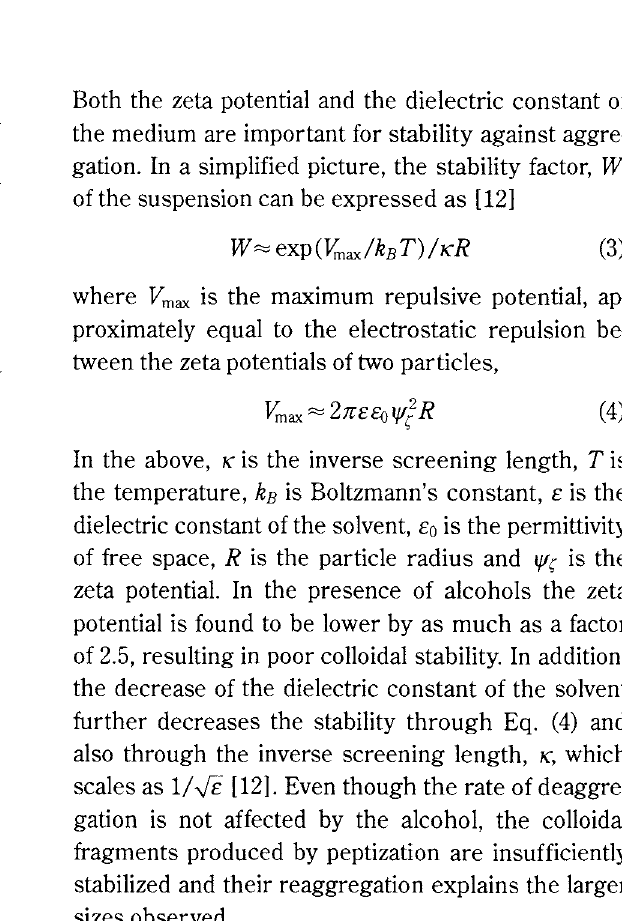
Table I Summary of results